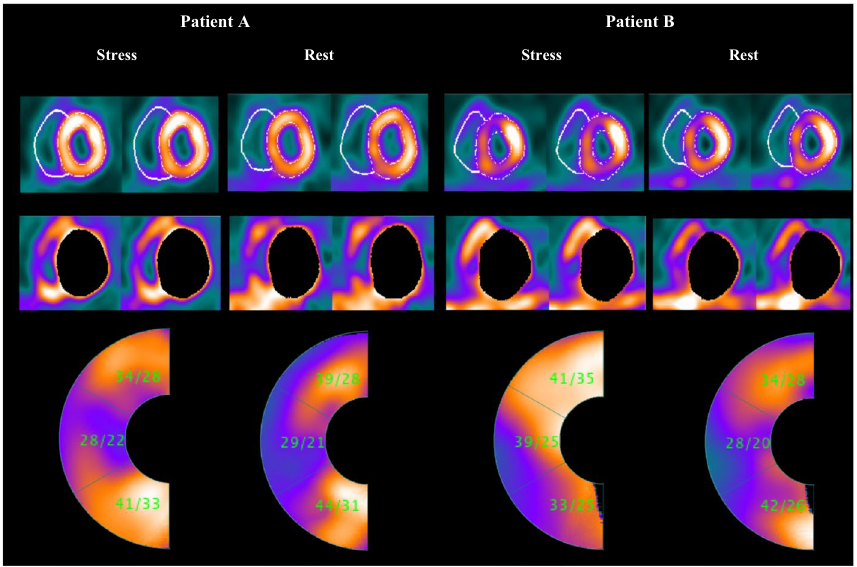
Fig. 5 The stress/rest scan for two sample patients. Patient A a normal individual with no significant CAD based on CA report. Patient B a 3VD patient based on CA report. For each individual, three rows of images are represented. First row: the short-axis image slices are represented. Second row: LV is extracted automatically by the proposed segmentation algorithm to enhance the RV visualization. Third row: the RV quantified polar map by proposed method. (The numerical values represent the maximal/average RV/LV uptake